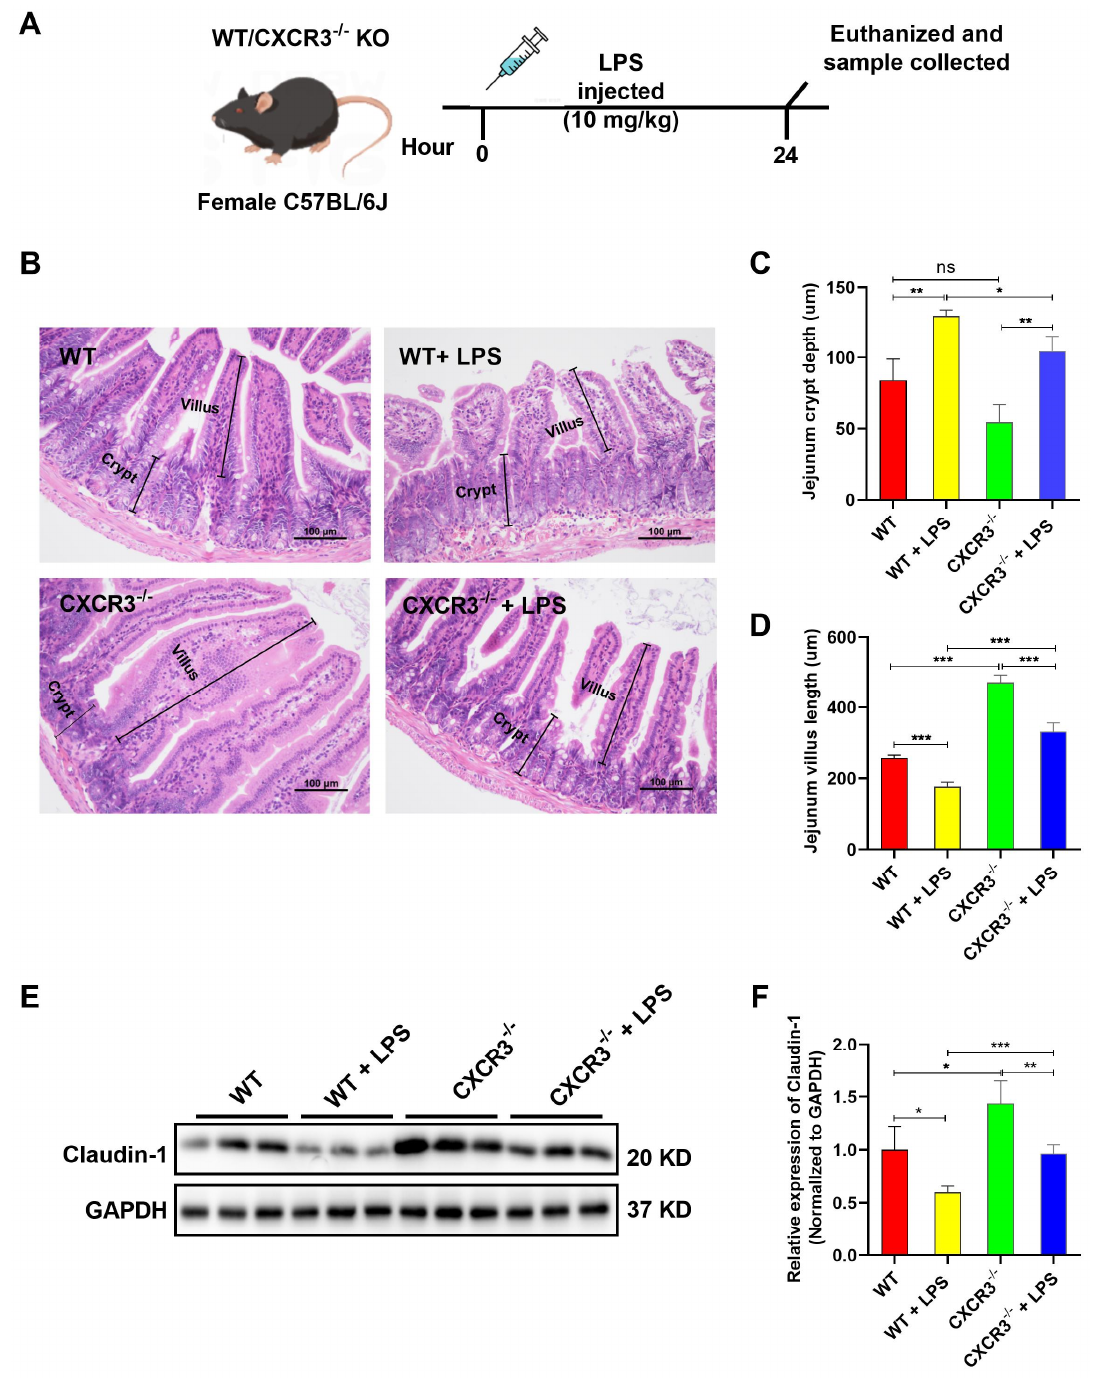
Figure 1. CXCR3 knockout attenuates intestinal epithelial structural damage and increases tight junction protein expression in the mouse intestine. C57BL/6J WT mice and CXCR3 − / − mice were intraperitoneally injected with LPS 10 mg/kg. After 24 h, the mice were sacrificed, and samples were collected. The jejunum tissue was fixed in formalin for HE staining and observed using an Olympus microscope. The protein was extracted for Western Blot. ( A ) Mice were intraperitoneally injected with LPS. ( B ) HE staining of jejunum tissue. ( C ) Intestinal villi height. ( D ) Crypt depth. ( E ) Claudin-1 protein expression. ( F ) Claudin-1 protein optical density value. The protein optical density value was analyzed by Image J 1.8.0 software (National Institutes of Health, Bethesda, MD, USA). Values represent the mean ± SEM. of three independent experiments. Significant differences are represented by * p < 0.05, ** p < 0.01, *** p < 0.001, and ns (not